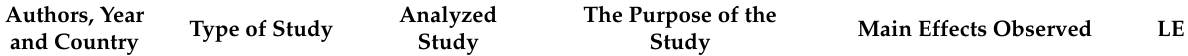
Table 4. Reviews identified to assess the role of intermittent fasting (IF) on obesity and